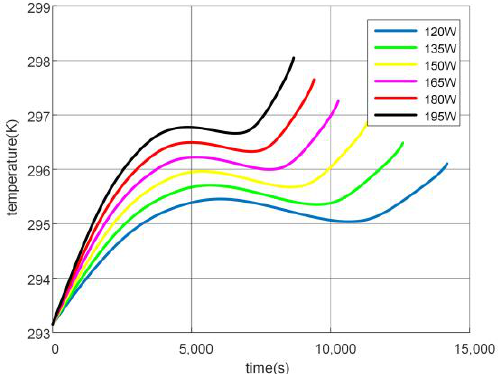
Figure 12. Maximum temperature change diagram under several constant power conditions.